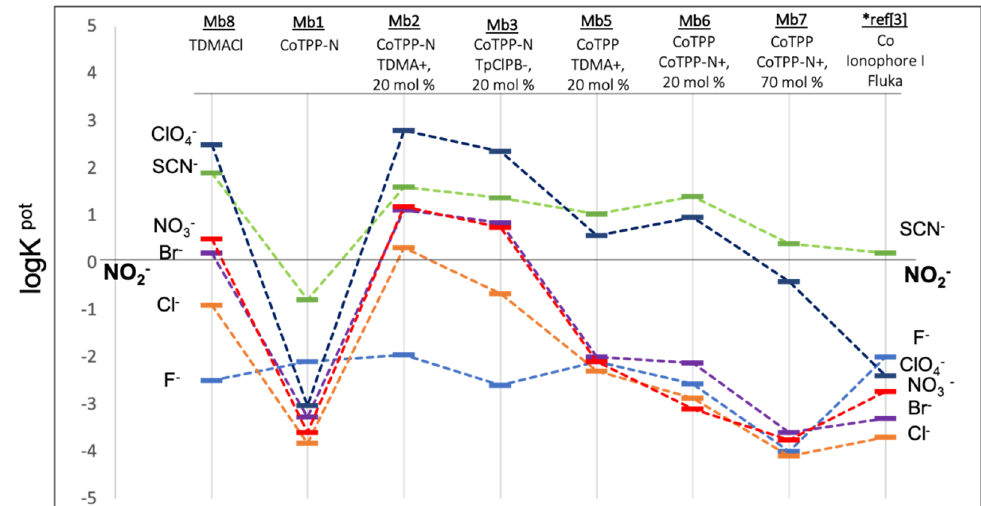
Figure 7. Selectivity coefficients values, logK NO2/Jpot , of tested membranes containing 1 wt.% of ionophore (CoTPP-N or CoTPP) and various amount of TDMACl and TpClPBK (indicated as mol% relative to ionophore content). All measurements were carried out in MES buffer, pH 5.5. The slope of − 57.8 mV/dec was used for calculus. For comparison, the selectivity of membrane Mb8 formulated only with 10 wt.% TDMACl is also shown.